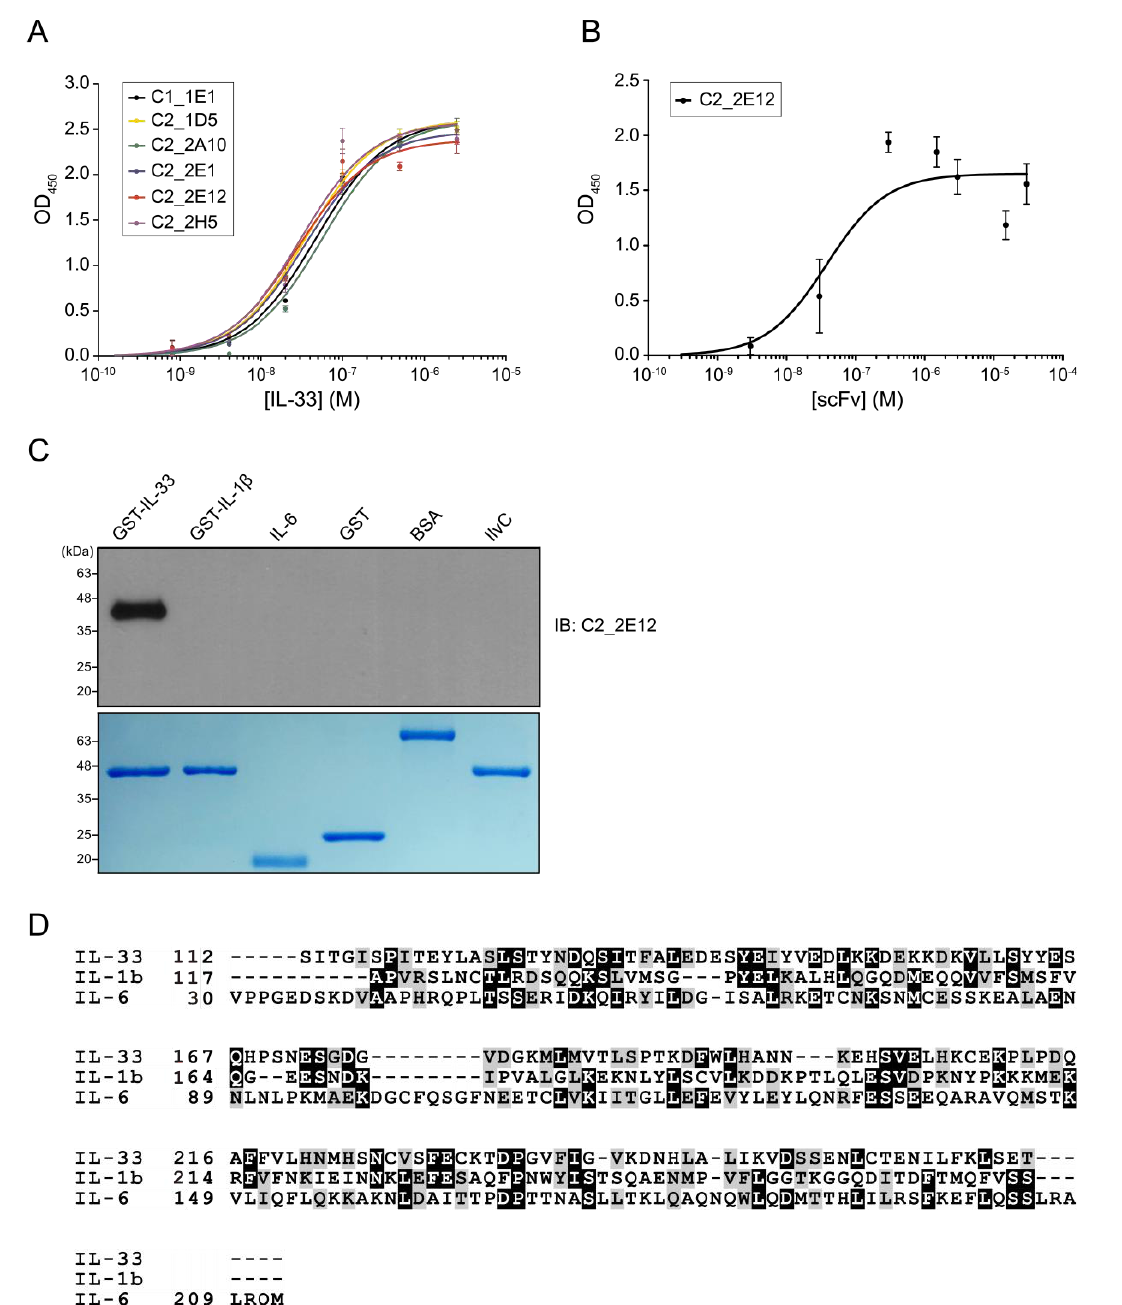
Figure 1. Molecular characterizations of anti-IL-33 single-chain antibody variable fragments (scFvs). Enzyme-linked immunosorbent assay (ELISA)-based affinity determination of anti-IL-33 scFvs. ( A ) Affinity determination of the top six clones that exhibited high binding signals against IL-33. ( B ) Affinity determination of the purified C2_2E12, which seems to have the highest binding signal and good protein condition among six clones. K d values of C1_1E1, C2_1D5, C2_2A10, C2_2E1, C2_2E12, and C2_2H5 were estimated by kinetic analysis. ELISA was repeated three times. ( C ) Immunoblot analysis of the recombinant proteins using C2_2E12 for primary antibody (0.5 mg·mL − 1 , 1:100 dilution) and anti-hemagglutinin-horse radish peroxidase (anti-HA-HRP) for secondary antibody (0.2 mg·mL − 1 , 1:5000 dilution). Expression of recombinant interleukin cytokines (GST-IL-33, GST-IL1 β , and GST-IL6) and unrelated proteins (GST, BSA, and IlvC) in E. coli BL21 (DE3) as revealed by SDS-PAGE analysis. IB, immunoblot. ( D ) Multiple protein sequence alignment of IL-33, IL1 β , and IL6. BSA: bovine serum albumin, IL: